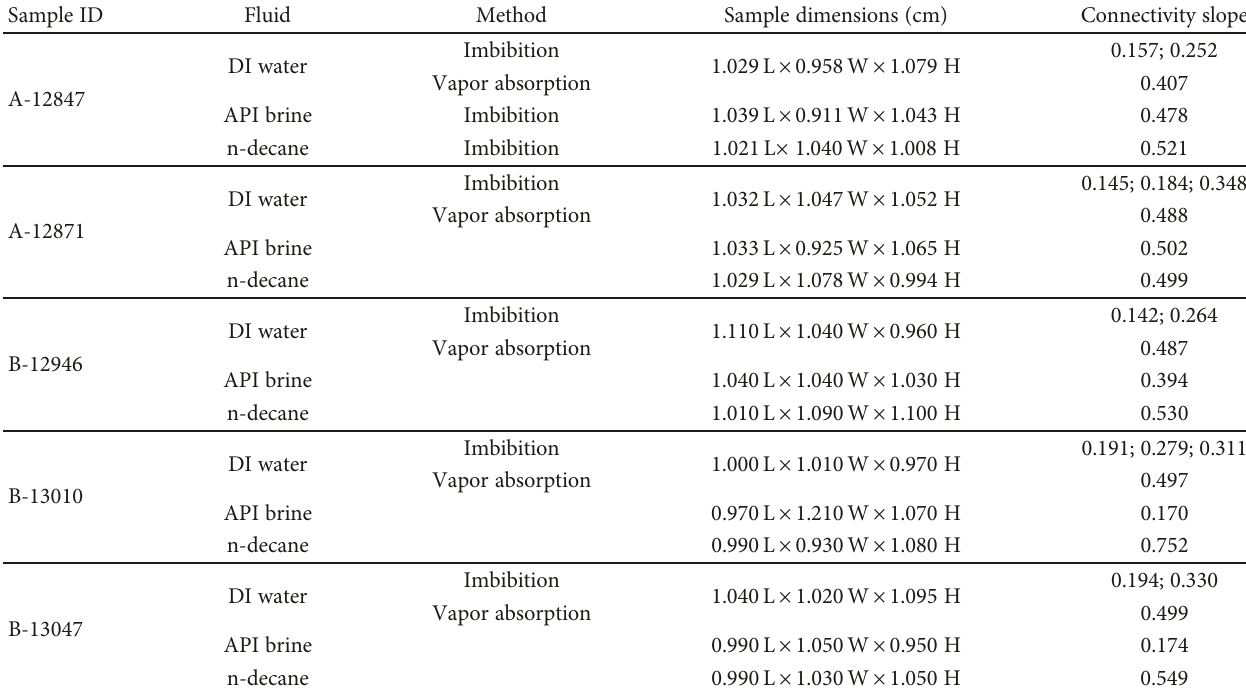
Table 4: Spontaneous imbibition test results. Both API brine and n-decane tests contain